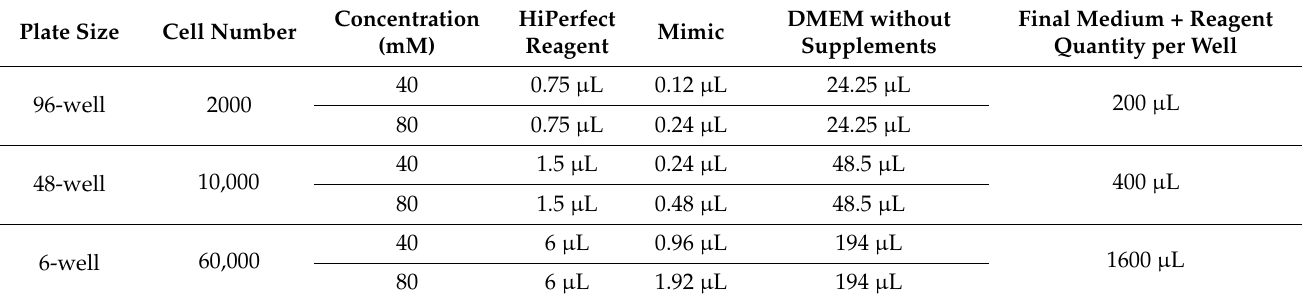
Table 2. Reagent quantities for miRNA mimic